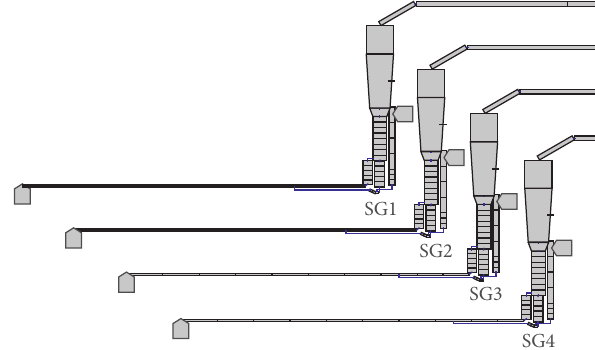
Figure 9: Thermal-hydraulic nodalization of 900MW CANDU steam generators secondary